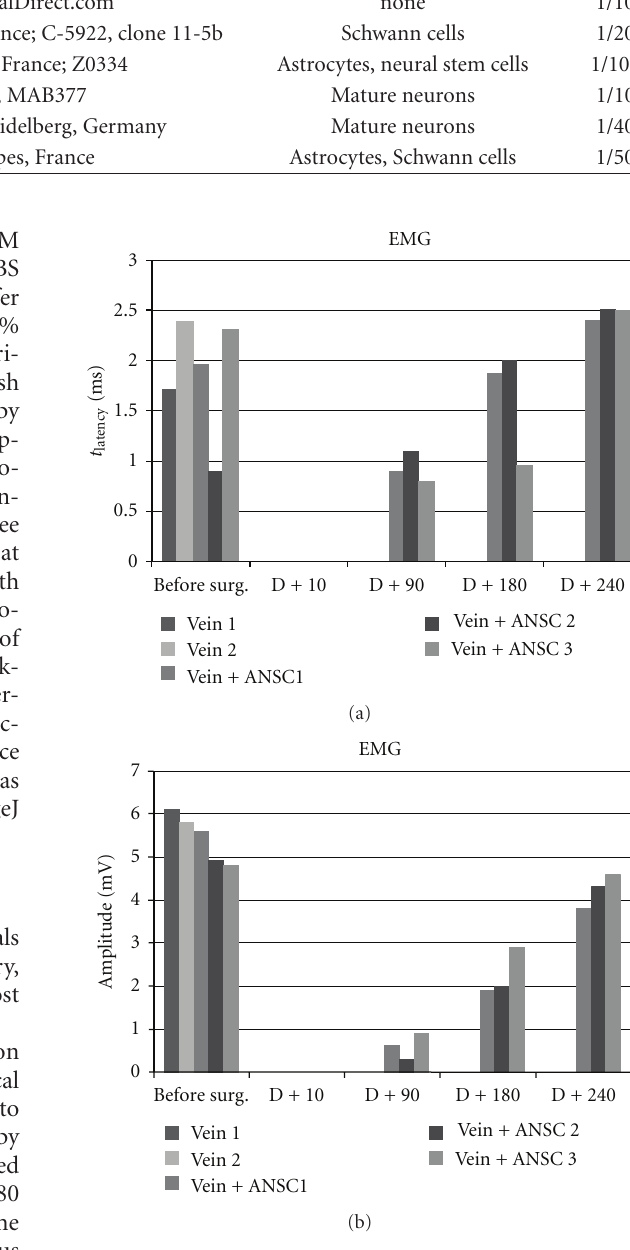
quadriceps with 0.6 to 0.9 mV amplitudes and 0.96 to 2 ms latencies, whereas electromyograms of control animals remained negative (Figure